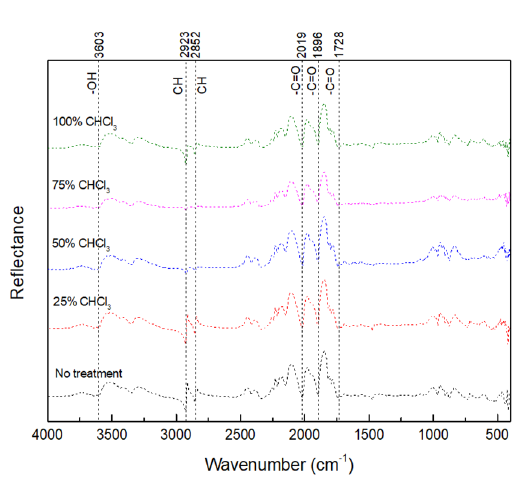
Figure 2. DR spectra in the 400 to 4000 cm -1 range of the PE treated at different C Cl